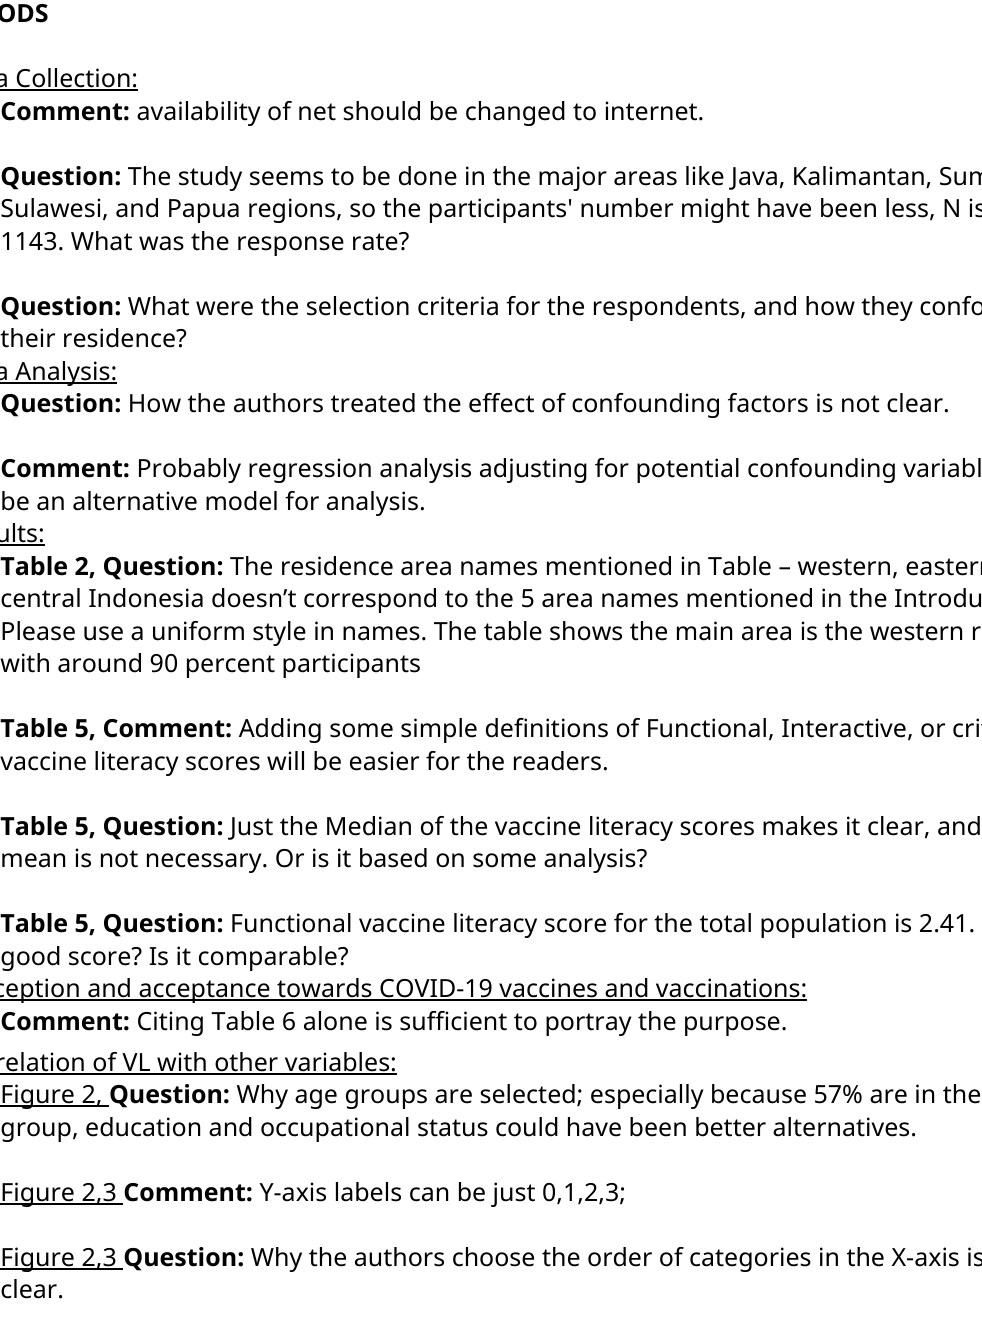
Figure 2,3 Question: Why the authors choose the order of categories in the X-axis is not